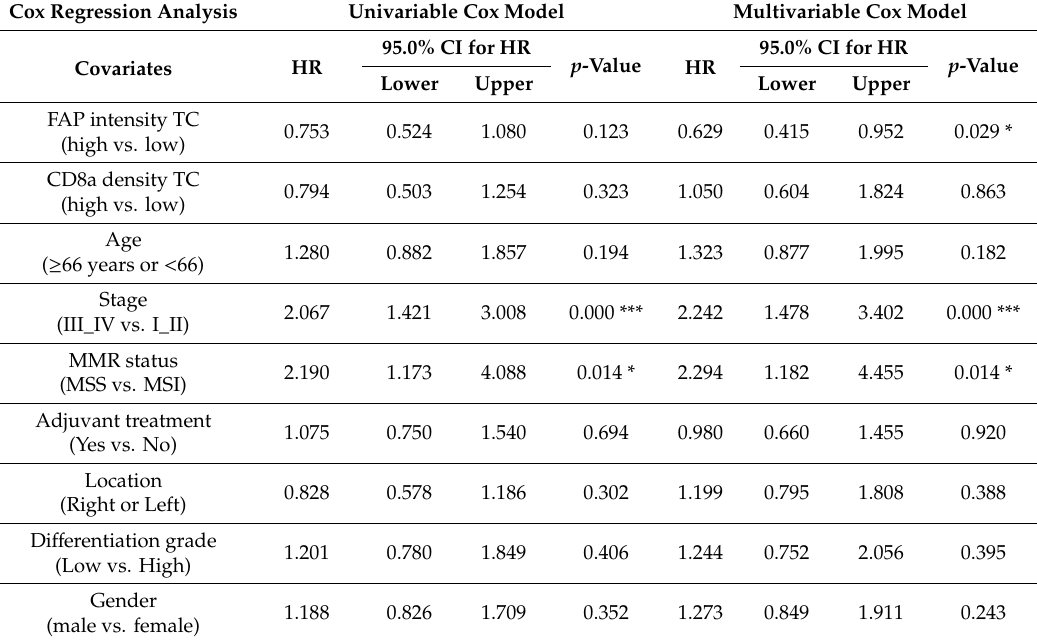
Table 2. Univariable and multivariable Cox models of FAP intensity and CD8a density predicting the overall survival of colon cancer patients in the “Nordic adjuvant randomized clinical